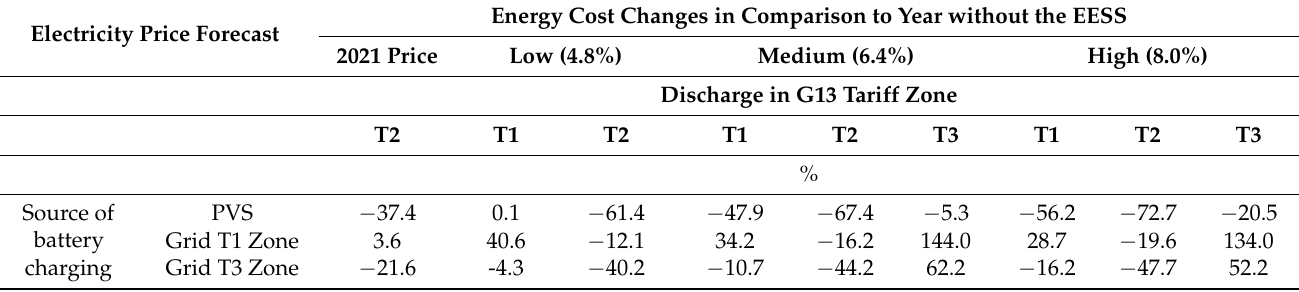
Table 5. Profitable combination of battery source charging and time zone their